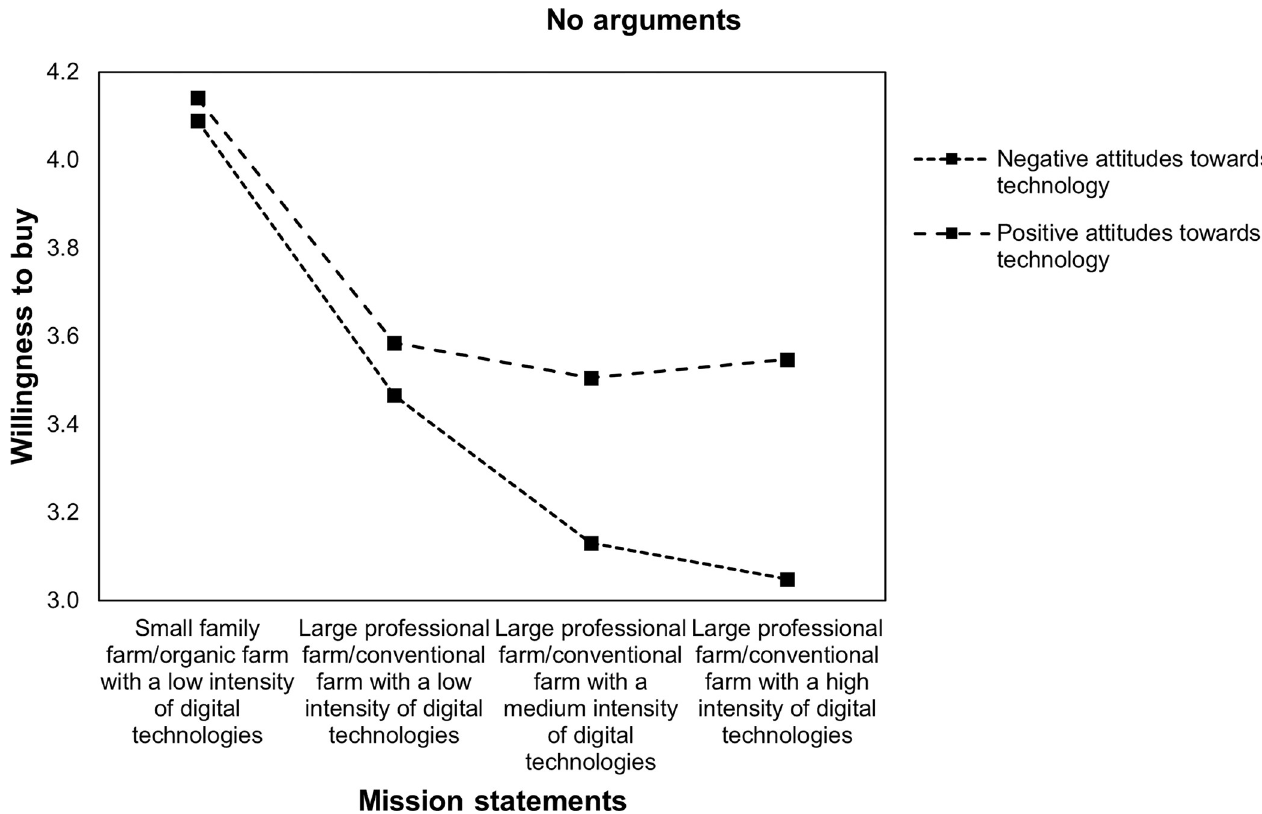
Fig 3. Profile plot of WTB food and attitudes towards technology without environmental arguments.